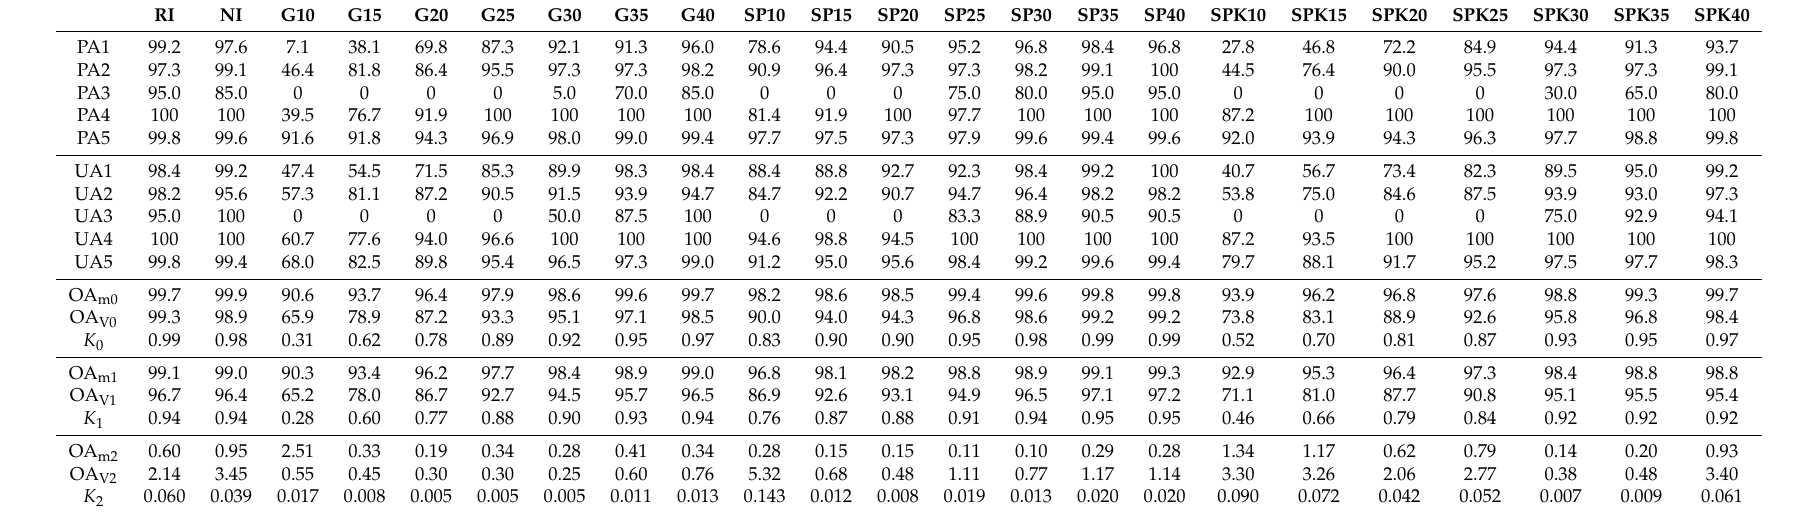
Table 3. Classification accuracies of the BPNN